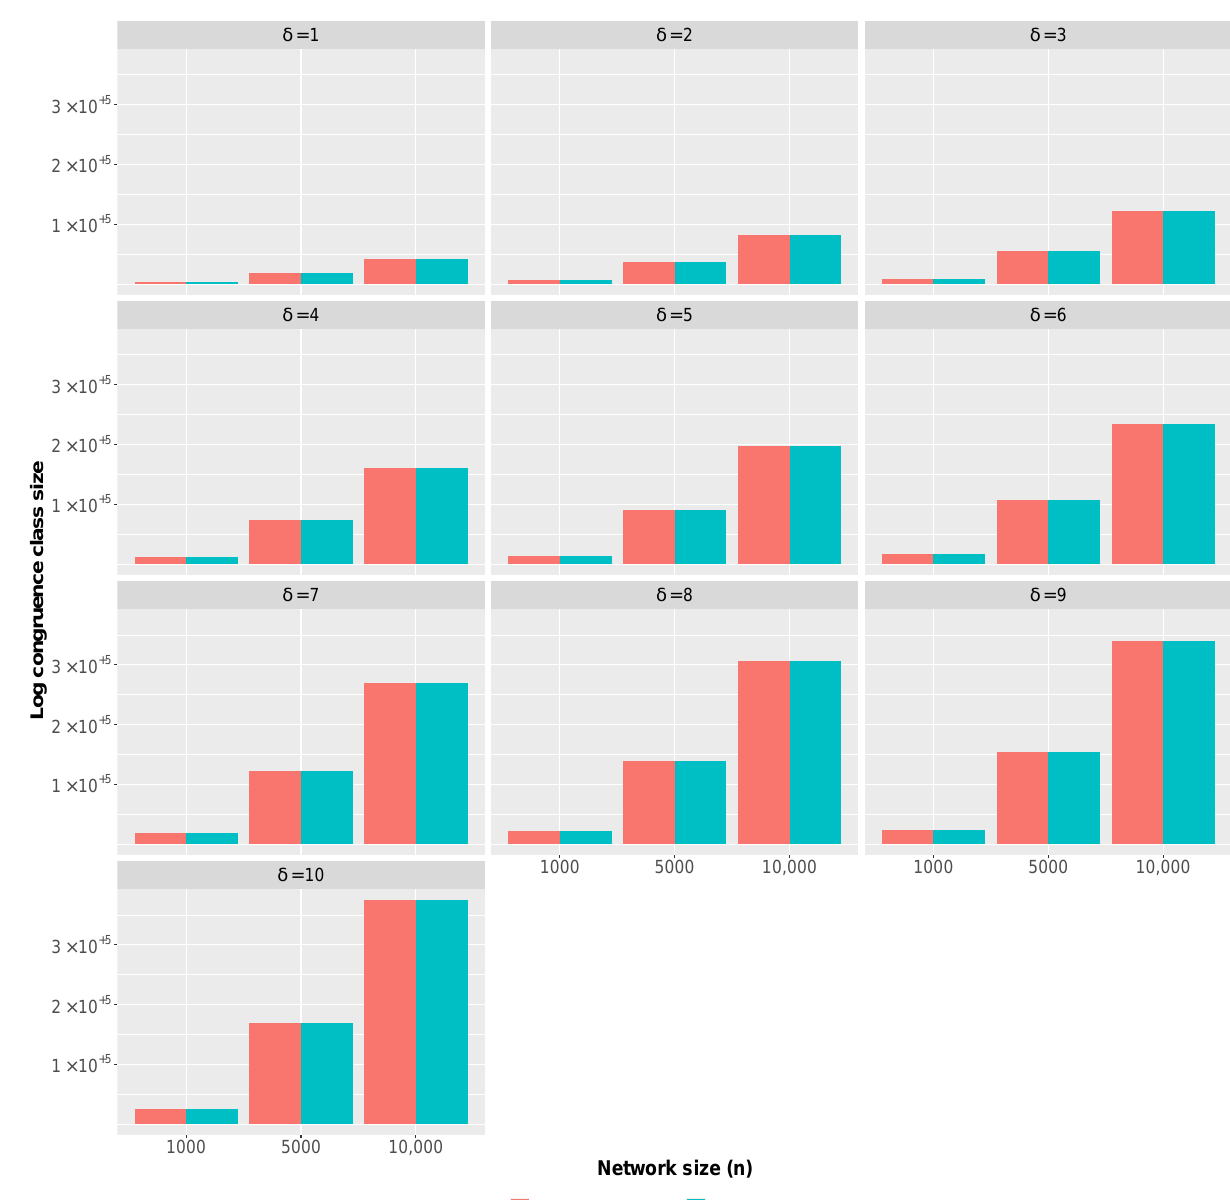
Figure 1. Comparison: Log estimates the number of δ -regular graphs for degrees from 1 to 10. The red bars depict estimates based on the recursive formula introduced in this paper; the blue bars are estimates based on Liebenau et al. [9]. Each plot shows log estimates for graphs of size 1000, 5000, and